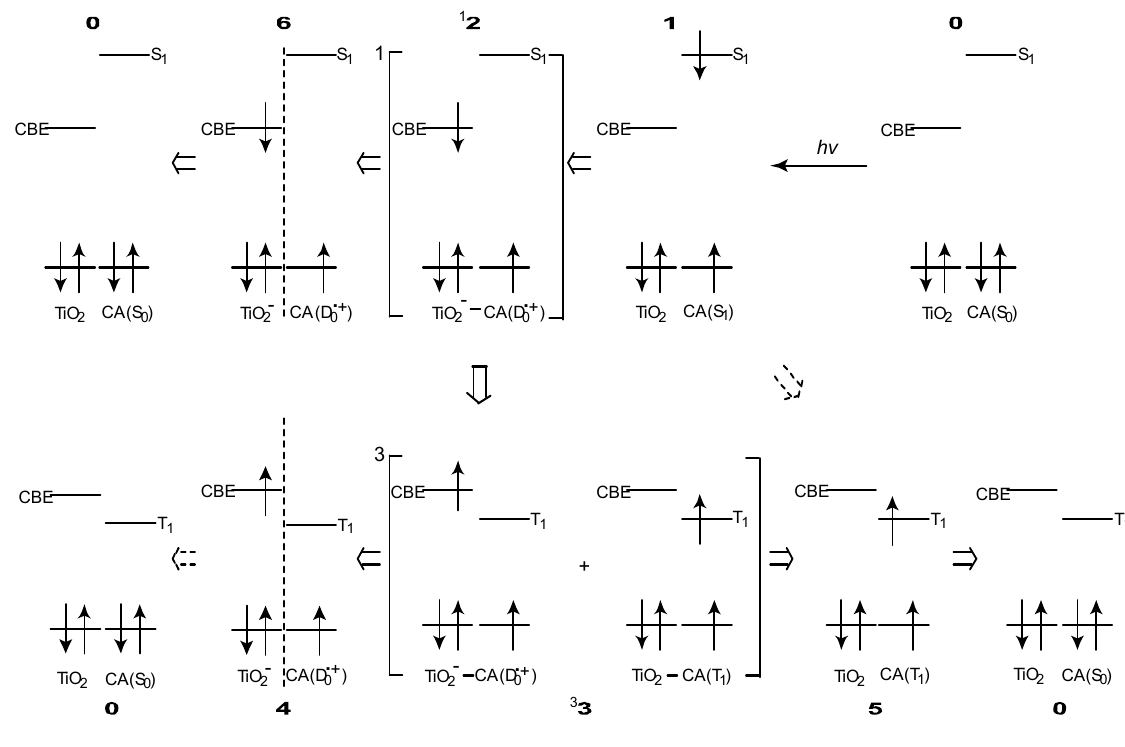
Figure 8. Excitation, electron transfer and relaxation dynamics in a typical RA or CA nanoparticles in suspension. Mechanisms of electron injection as well as bound to TiO 2 charge recombination, following intersystem crossing and exciplex formation, to generate  + ) species of the sensitizer. Each numbered state is ) and radical cation (D triplet (T 1 0 expressed by a combination of TiO and CA in the ground, redox or excited states 2 (reprinted from [4] with permission of the American Chemical